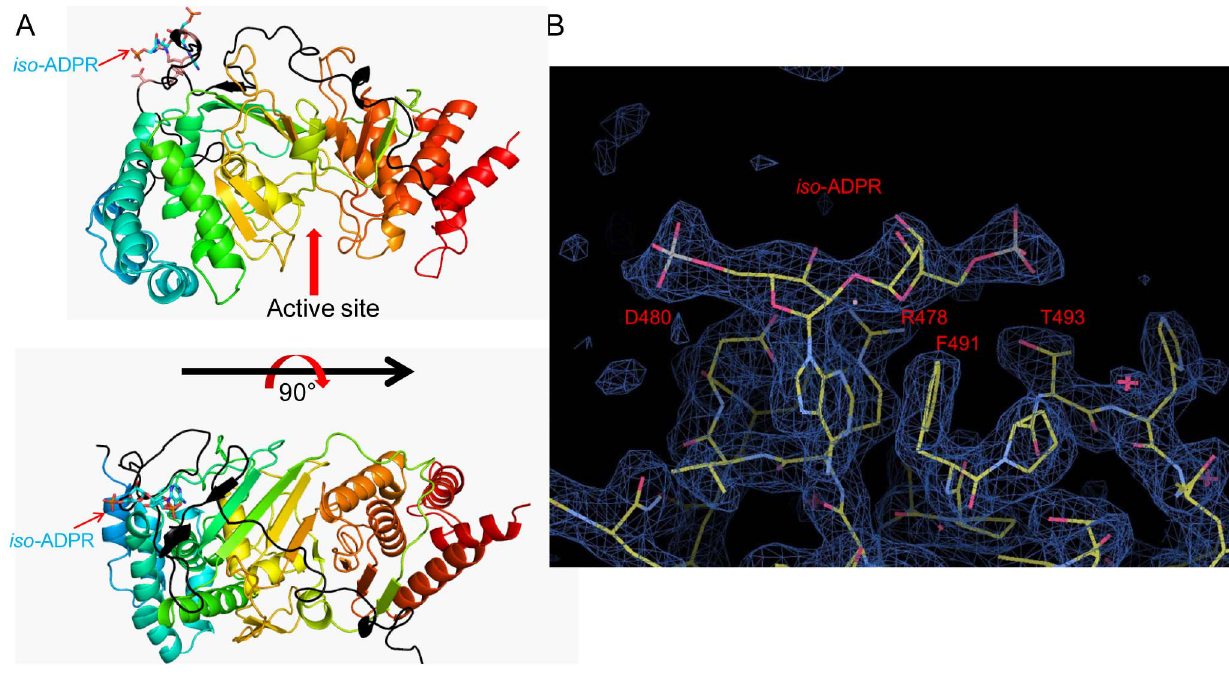
Figure 3. A potential secondary iso -ADPr binding site. (a) A possible secondary binding site. iso -ADPr is showed in cyan stick. The bound iso - ADPr is close to the Exon4 + 5 encoded region (highlighted in black). (b) The 2Fo-Fc simulated annealed omit map of the potential secondary iso -ADPr binding region, calculated using the CNS package and contoured at 1.5 s . The iso -ADPr was omitted and simulated annealing was performed to remove model bias prior to electron density calculation. It is also apparent that the iso -ADPr molecule in this position is not restricted by crystal packing.